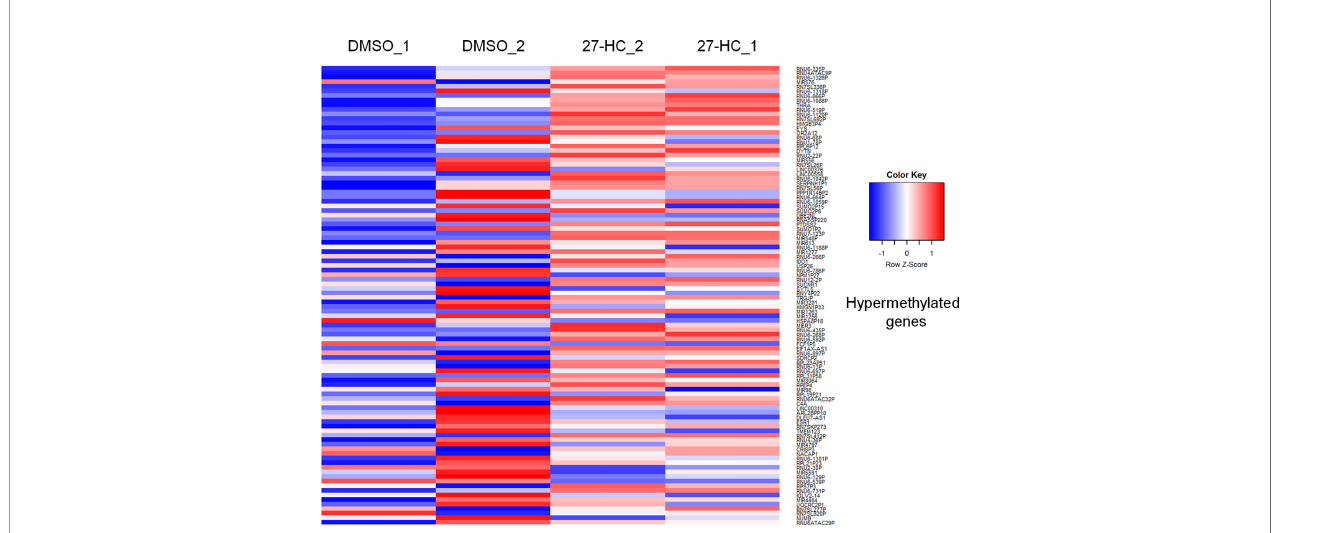
FIGURE 1 | Identi fi cation of aberrant DNA methylation signatures: The heatmap represents the hypermethylation in 27-HC treated samples. The heatmaps were generated using beta values obtained from fl uorescence intensity from the array scanning and the hypermethylated genes are with beta values greater that 0.5 fold change (treated > 0.5 compared to control) .The genes which showed signi fi cant DNA hypermethylation are phosphatidylserine synthase ( PTDSS2 ), mir613, indoleamine 2,3-Dioxygenase 1 (IDO1), thyroid hormone receptor alpha (THRA), Dystrotelin (DTYN), Mesoderm induction early response 1, family member 3 (MIER) . The hypermethylated genes are shown in red color. The list of genes was taken for analysis from bisul fi te sequencing ( Supplementary Data, S1 )